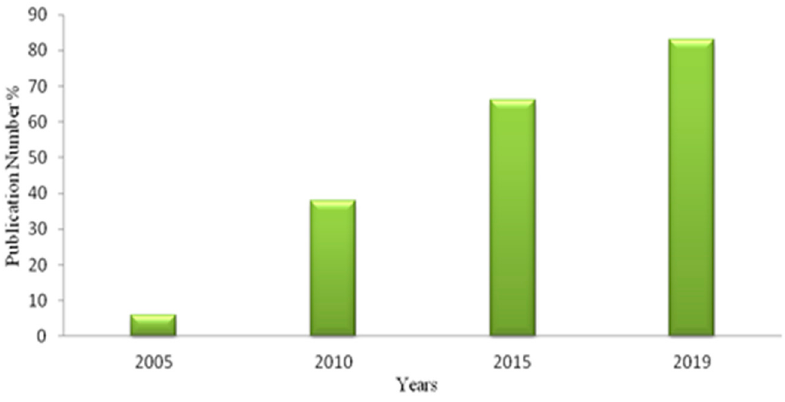
Figure 5. Publication trends in field of nanomaterial for wastewater treatment.